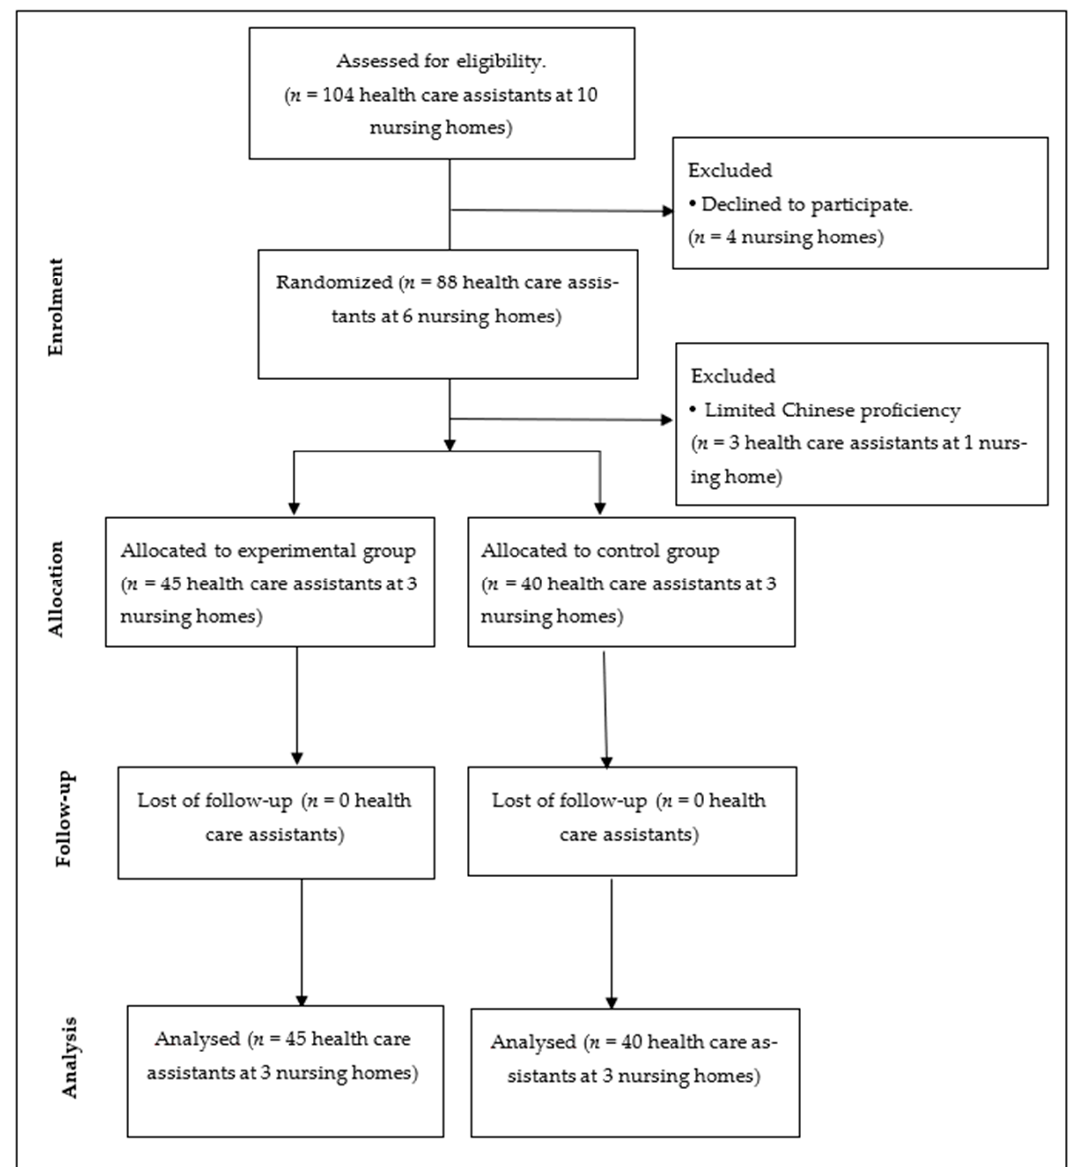
Figure 1. Sampling and flow of subjects.